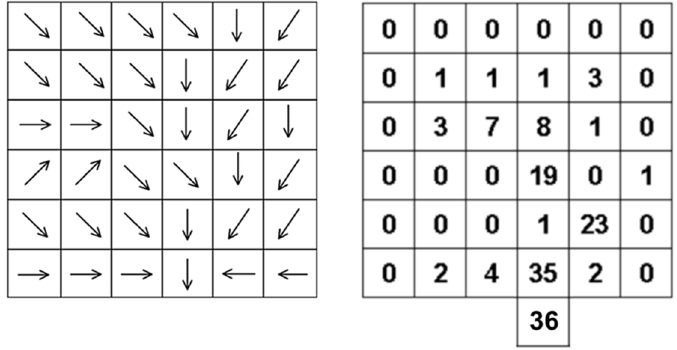
Figure 4. The path of water flow determined by the flow directions